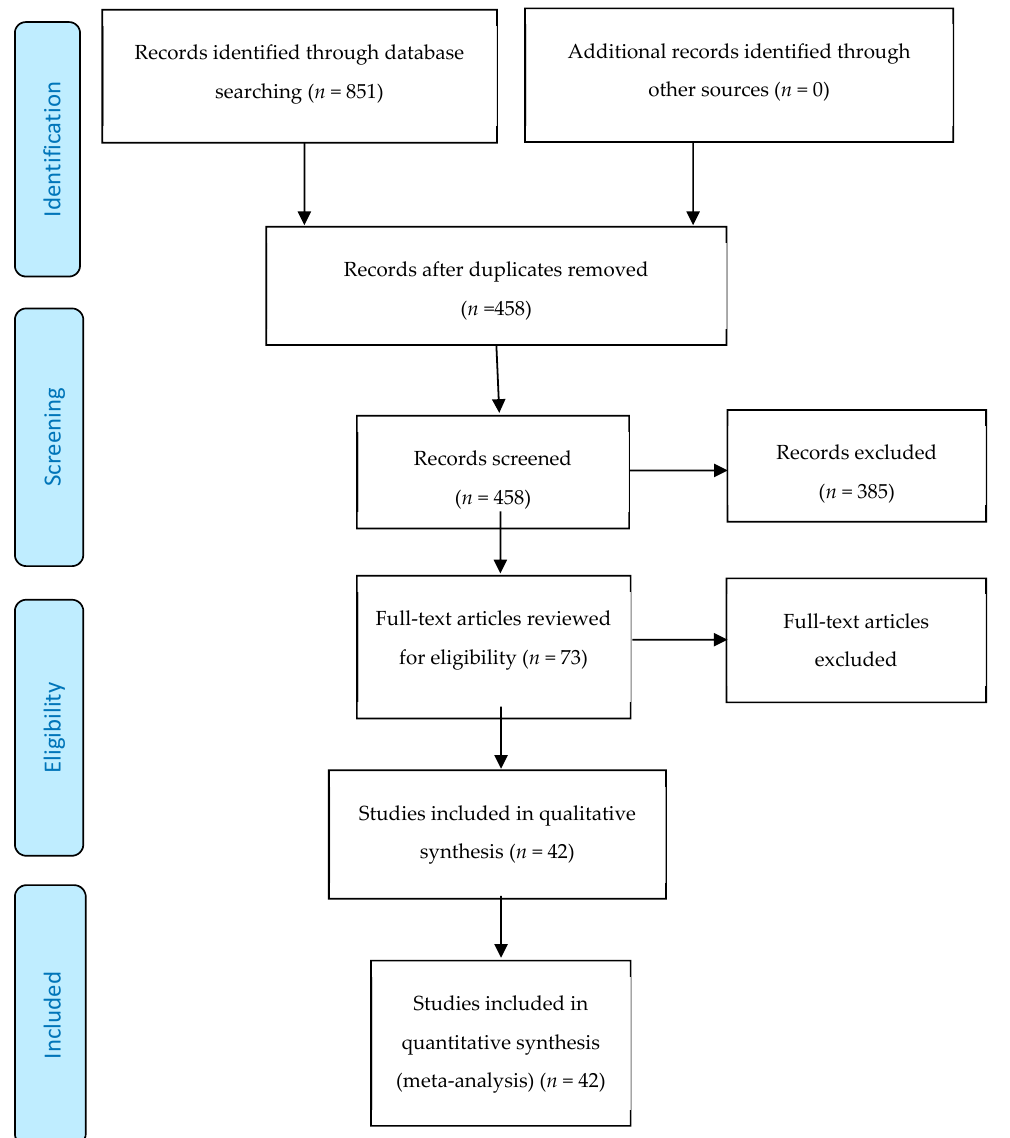
Figure 1. Prisma flowchart of screening and selection.